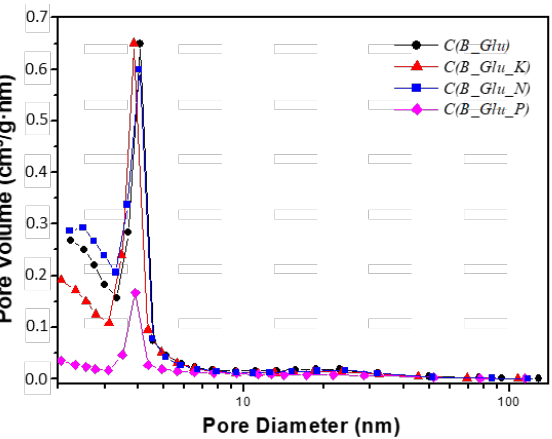
Figure 6. Pore size distribution of the synthesized carbons (BJH desorption dV/dD pore volume).